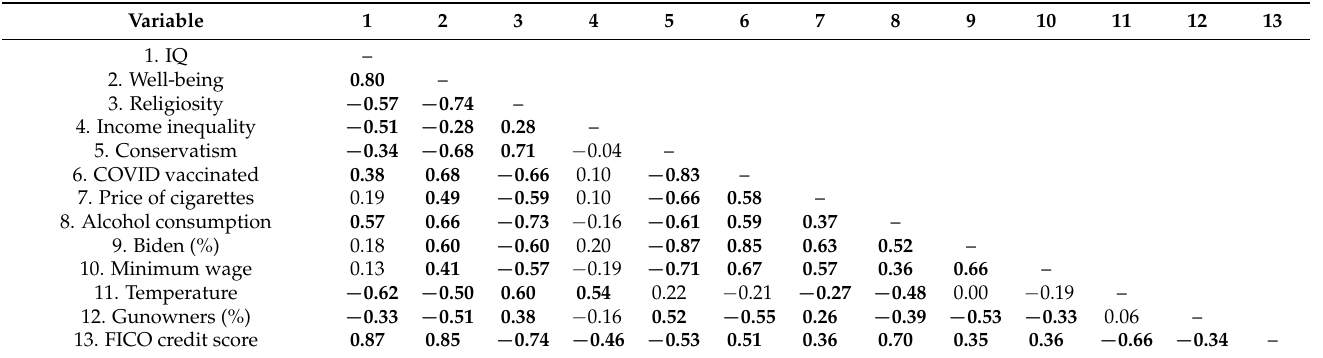
Table 3. A well-being nexus of correlations, including IQ, global well-being, and various state-level measures of